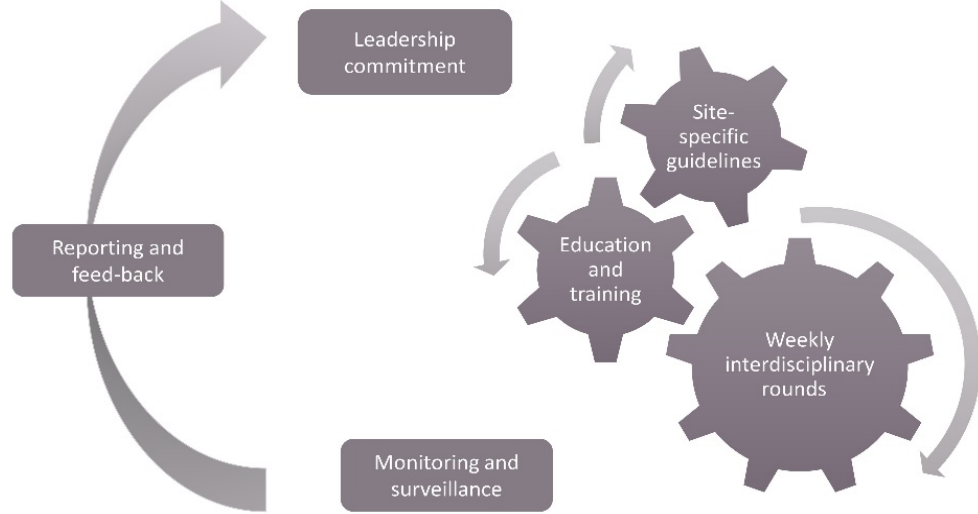
Figure 4. The antimicrobial stewardship intervention in the urology